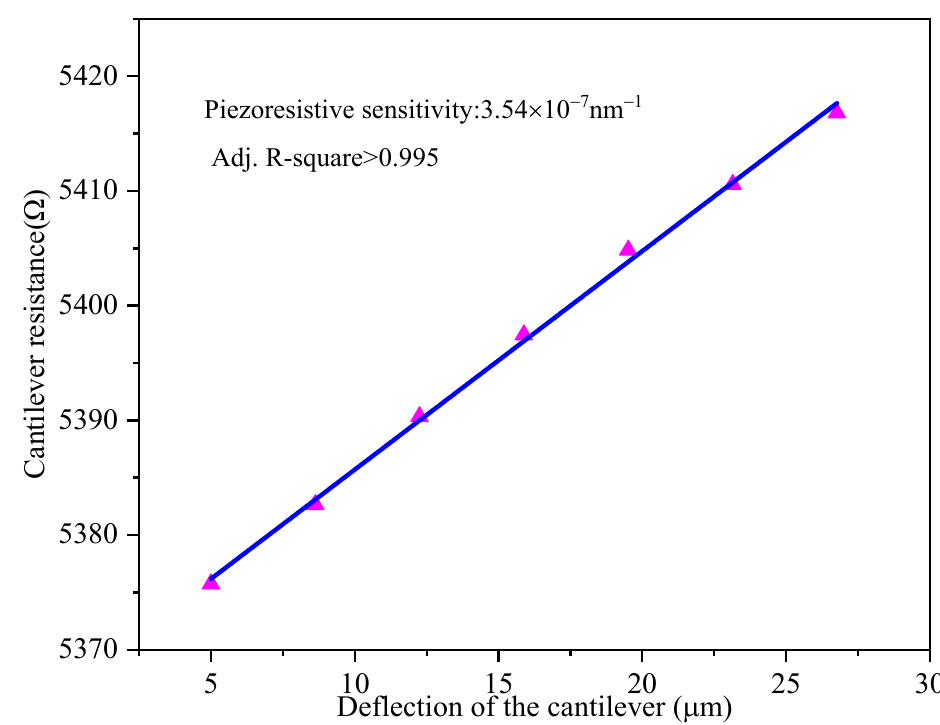
Figure 6. The sensing microcantilever resistance change vs. deflection of the free end for PI/Si/SiO 2 microcantilever. The value of the piezoresistive gauge factor can be calculated by Equation (5) of ref ‐